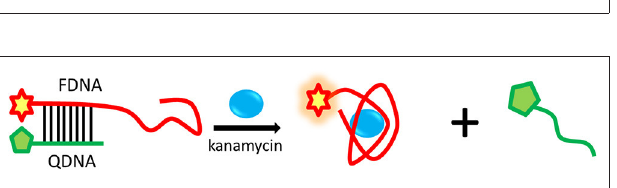
Atlantis C 18 chromatographic column (3.5 µ m, inner diameter: 150 × 2.1 mm), the column temperature was 40 ◦ C, and the sample intake was 30 µ L. The mobile phase A was 0.1% aqueous formic acid, mobile phase B was 0.1% acetonitrile formate and mobile phase C was methanol. Mass spectrometry conditions were electrospray ion source (ESI), positive ion scanning and multi-reaction monitoring (MRM). The electrospray voltage, the auxiliary gas flow rate, auxiliary gas temperature and the focusing voltage were 5 V, 7 L/min, 550 ◦ C, and 150 V, respectively. Two ion pairs at 485/163 and 485/324 of m / z were used for qualitative analysis and external standard method for quantitative